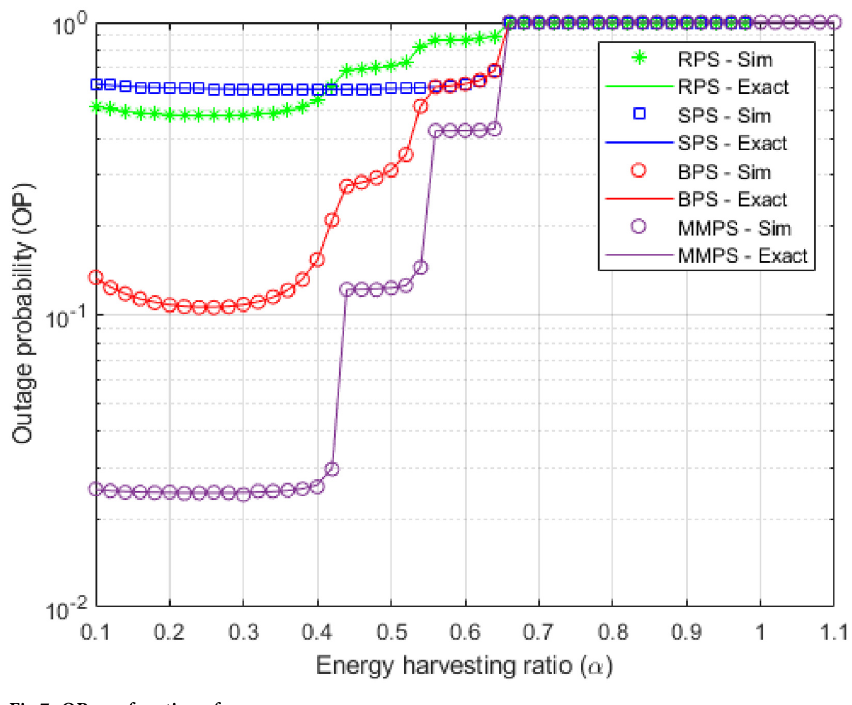
Fig 7. OP as a function of α .